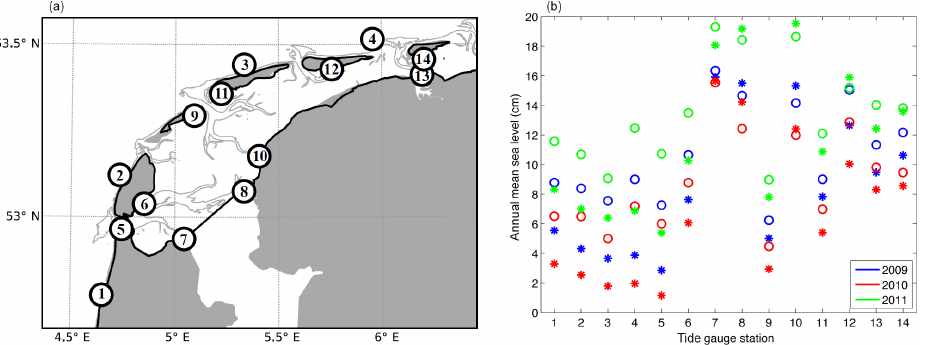
Figure 10. Annual mean sea level for the years 2009–2011: comparison between model results (asterisks) and observations (circles) for fourteen tide gauges in and around the Dutch Wadden Sea, whose positions are indicated in the map on the left.